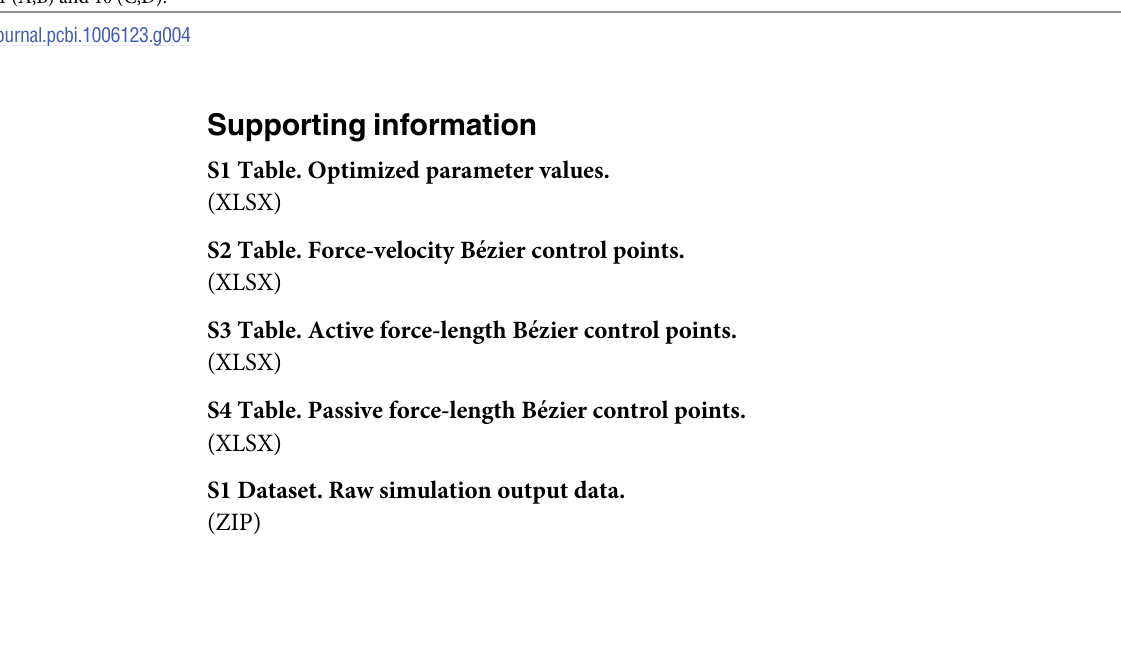
Fig 4. Output simulation work-loops. Muscle work-loops showing normalized muscle force ^ F with u max of 0.1 are shown in panels A and C, and simulations with u max of 1 are shown in B and D. The non-dimensional muscle forces and lengths are identical for simulations with l of 1 (A,B) and 10 l 0